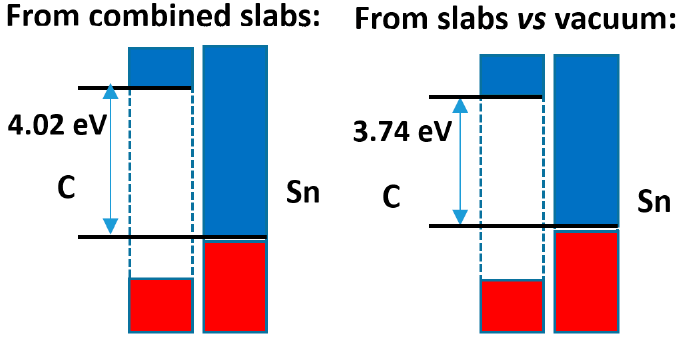
Figure 10. Band offsets found for the diamond-type C| α -tin case.